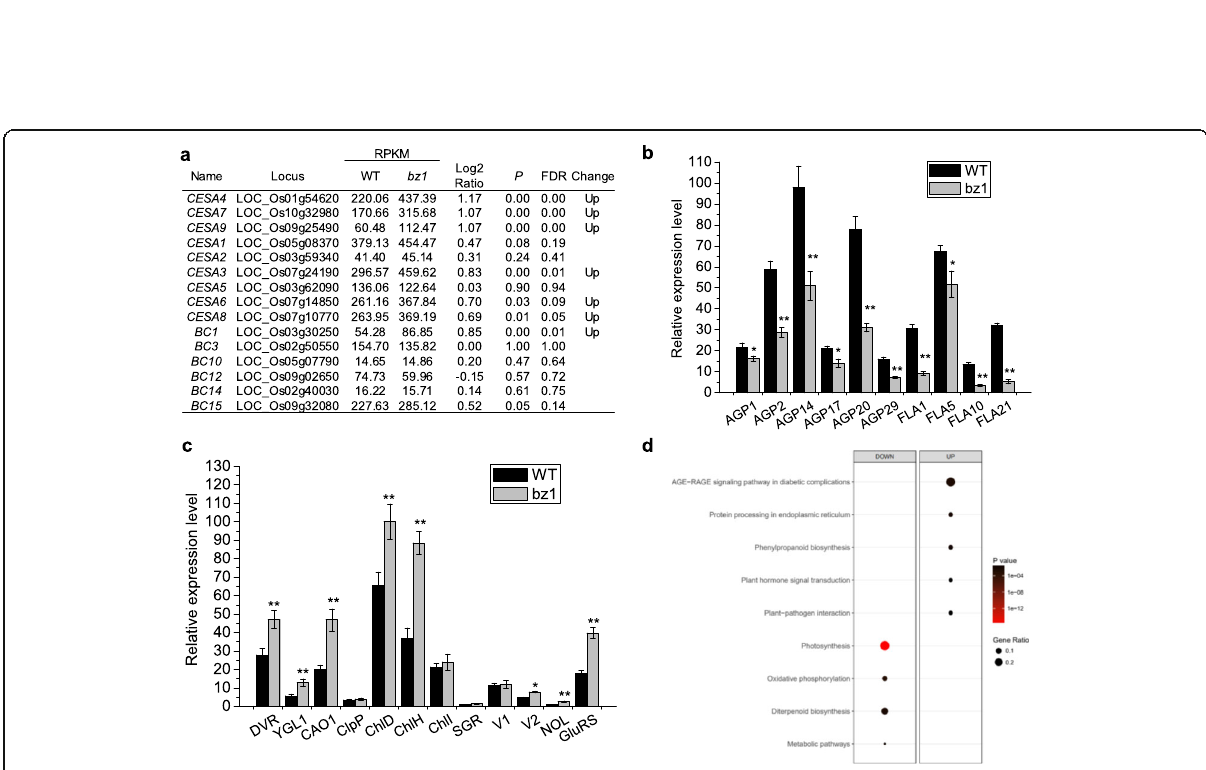
Fig. 7 Transcriptome profile analysis of both stem and leaf tissues in wild-type (WT) and bz1 by RNA-sequencing approach. a Expression levels of CESA ( Cellulose Synthase ) and BC ( Brittle Culm ) genes in WT and bz1 plants based on stem RNA-sequencing analysis. ( b ) qRT-PCR analysis of AGPs biosynthesis related genes in second stem internodes of WT and bz1 plants at the heading stage. c qRT-PCR analysis of representative genes involved in chloroplast development and chlorophyll biosynthesis using the top leaves of WT and bz1 plants at the tillering stage. d KEGG enrichment analysis was performed to identify the altered pathways of differentially expressed genes (DEGs) based on leaves RNA-sequencing analysis. * and ** indicates significant differences between WT and bz1 by t -test at P < 0.05 and 0.01, respectively